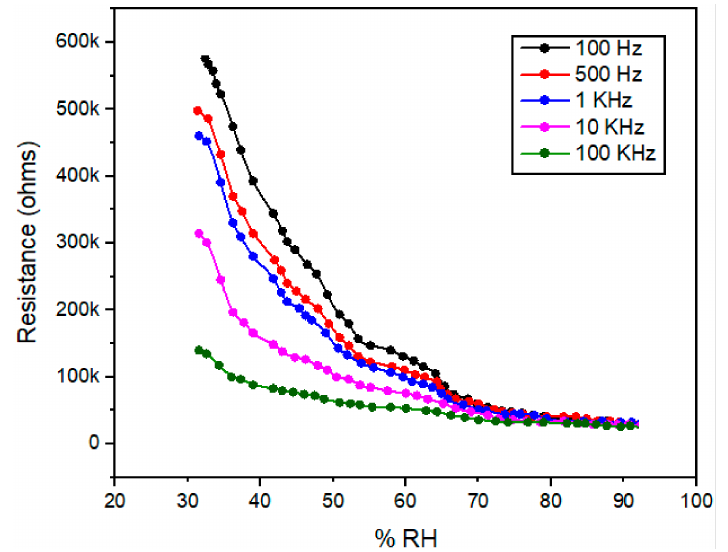
Figure 9. Resistance verses % RH response of Ppy composite based thin film sensor at five different frequencies and 1